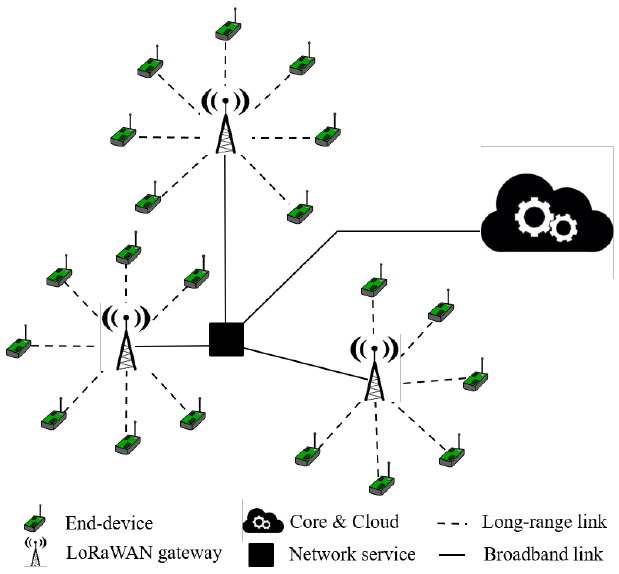
Figure 3. LoRaWAN network